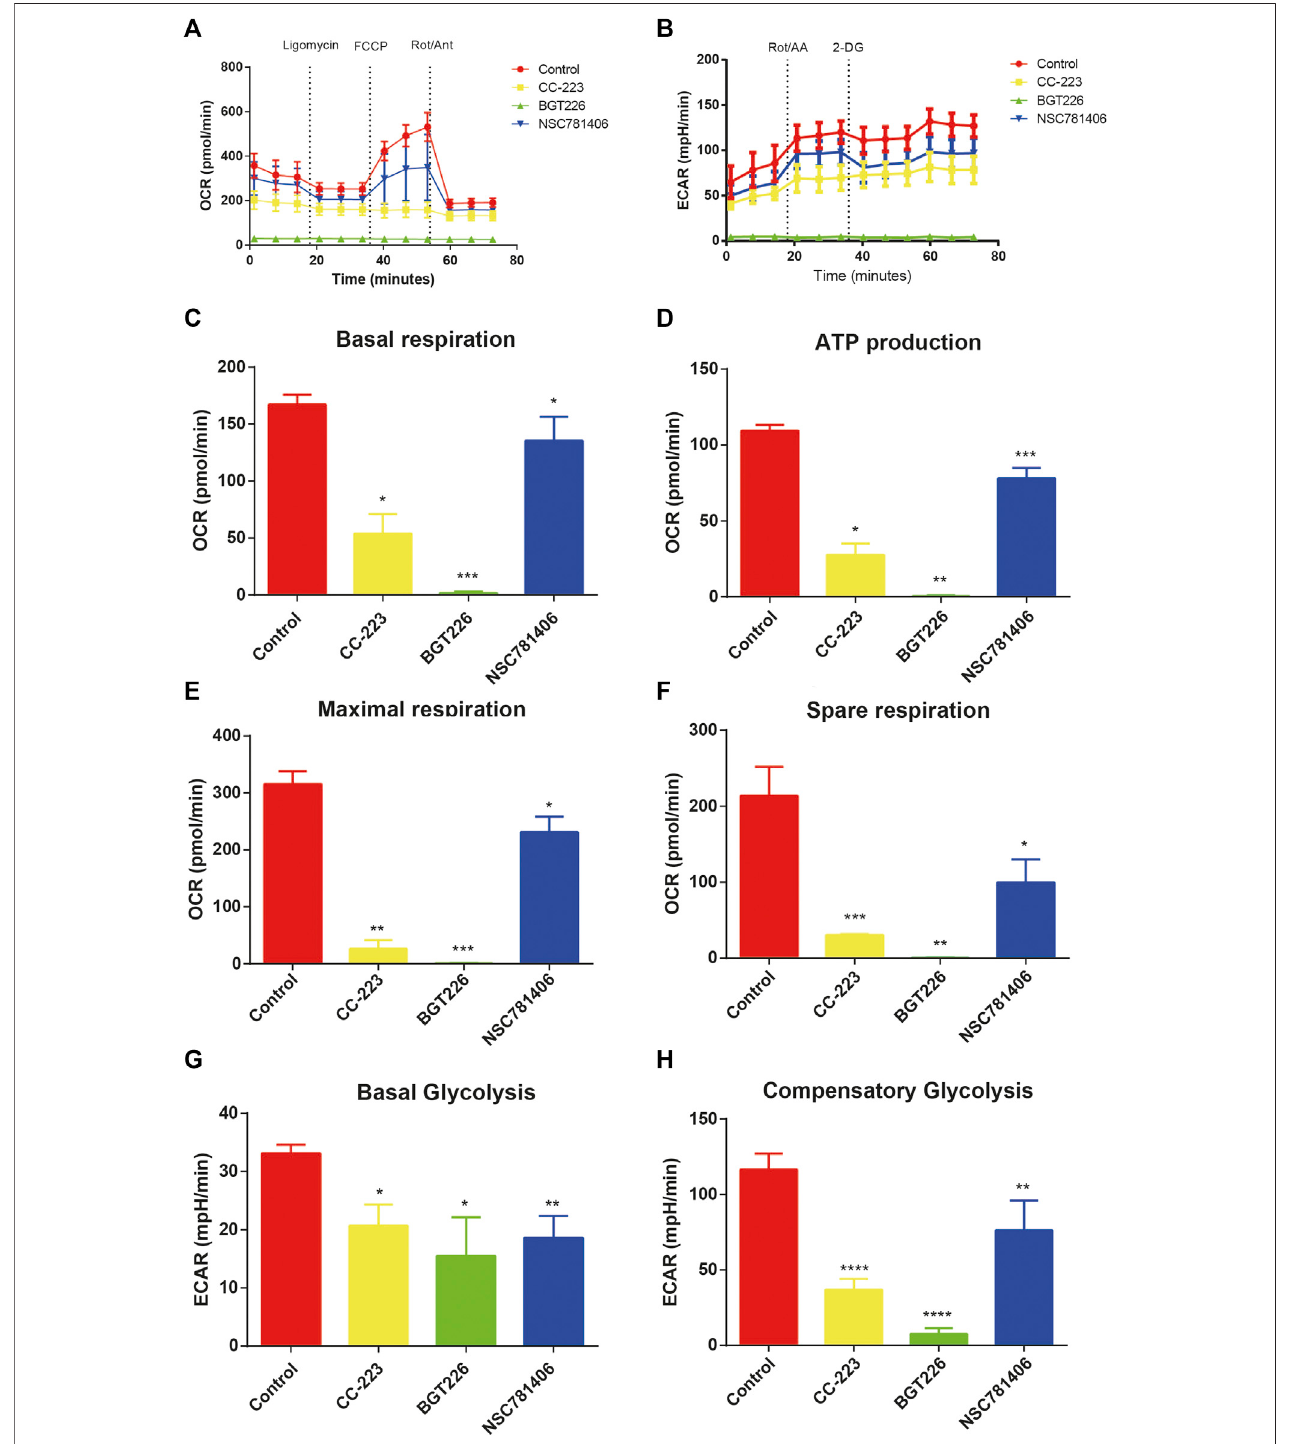
FIGURE 4 | CC-223, NSC781406, and BGT226 inhibit glycolysis in PANC-1 cells. (A) OCR assay. Cells were treated with 20 μ M CC-223, NSC781406, and BGT226 for 24 h. (B) ECAR assay. Cells were treated with 20 μ M CC-223, NSC781406, and BGT226 for 24 h. (C) Statistical bar chart of the basal respiration. (D) Statistical bar chart of the ATP production. (E) Statistical bar chart of the maximal respiration. (F) Statistical bar chart of the spare respiration. (G) Statistical bar chart of the basal glycolysis. (H) Statistical bar chart of the compensatory glycolysis. * p < 0.05; ** p < 0.01; *** p < 0.001; **** p < 0.0001.